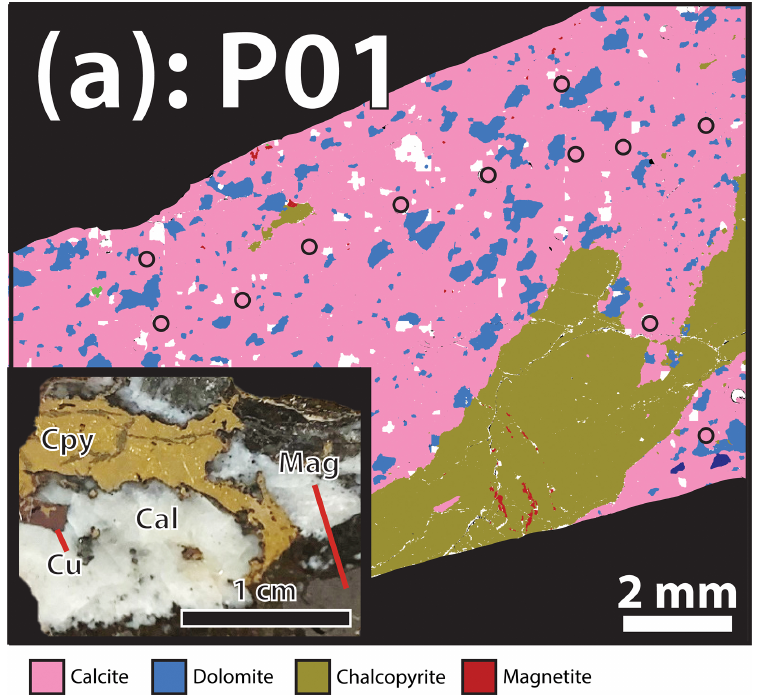
Figure C1. Large image of sample P01 from Phalaborwa carbonatite, South Africa. Large images shows SEM mineral map. Inset shows hand sample photo. Cpy: chalcopyrite; Cu: cubanite; Cal: calcite; Mag: